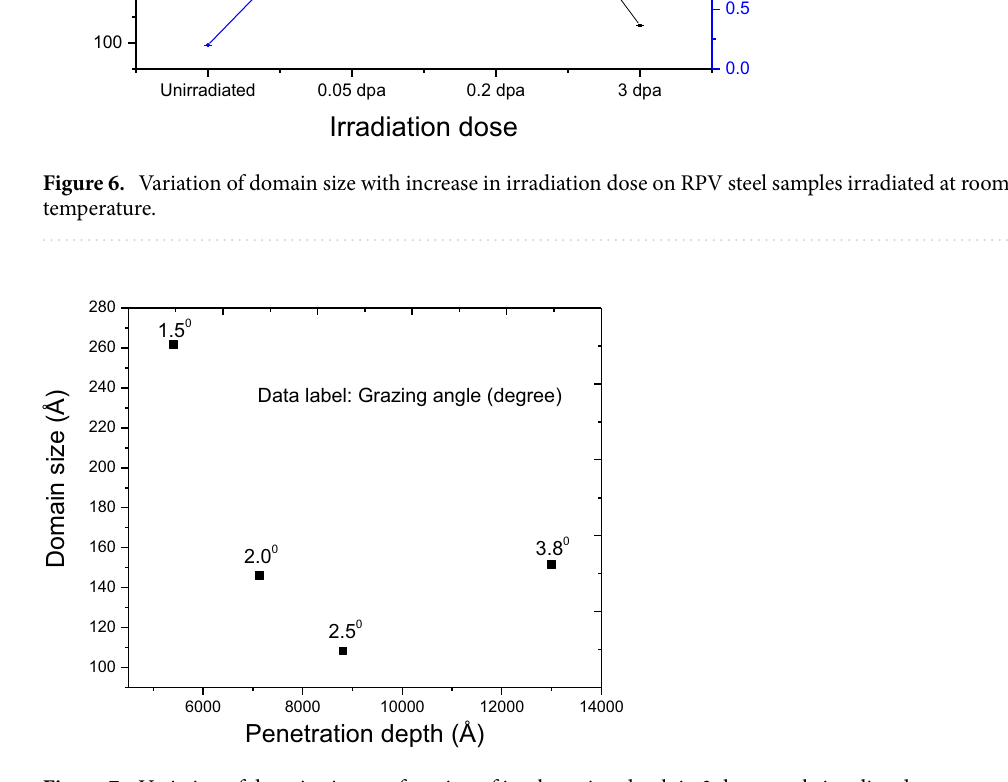
Figure 7. Variation of domain size as a function of implantation depth in 3 dpa sample irradiated at room